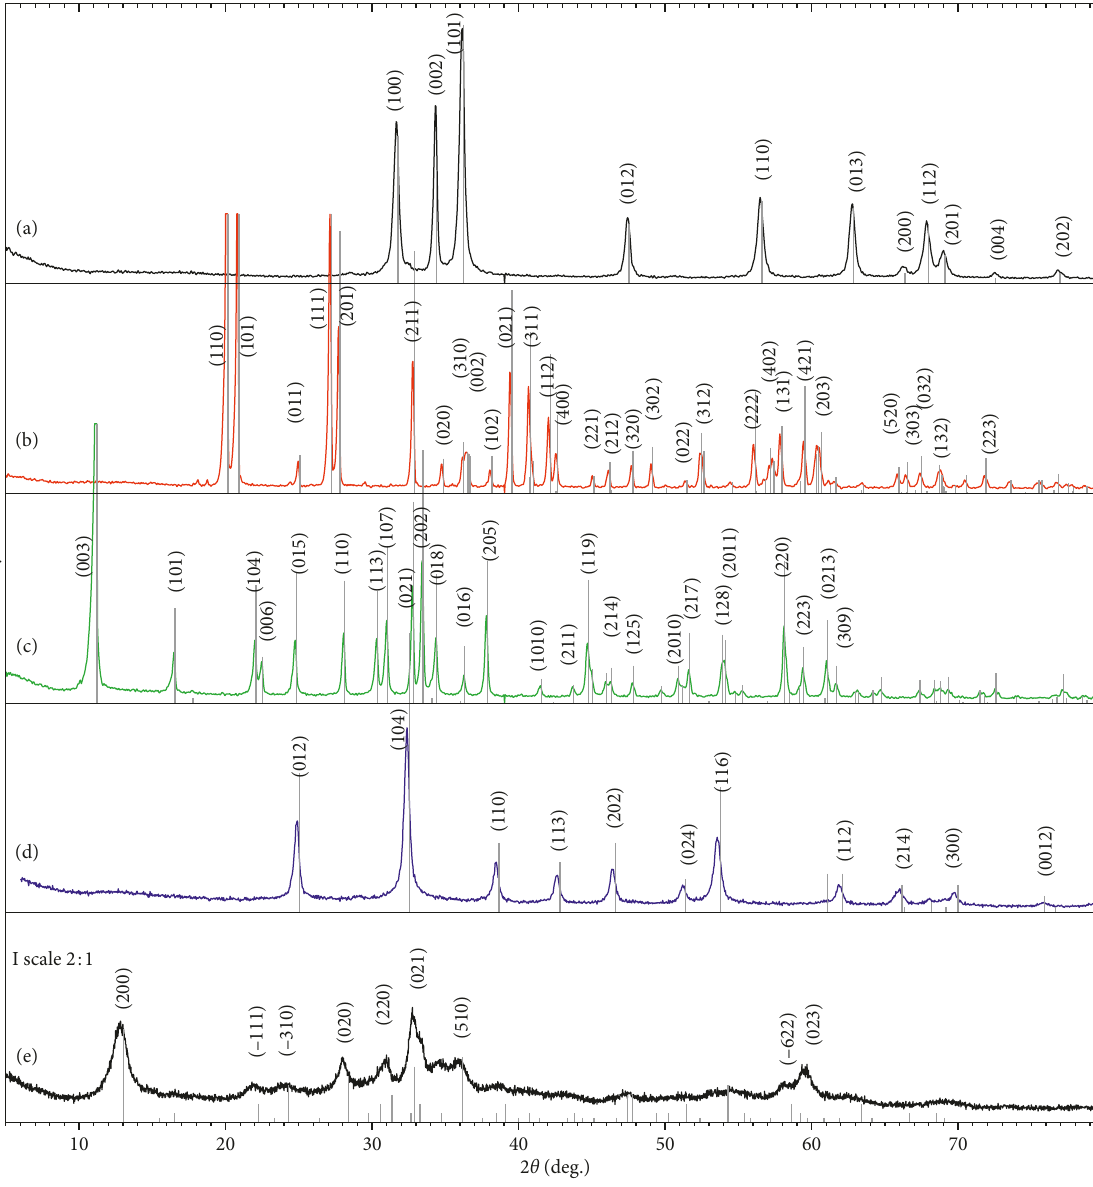
Figure 1: XRD patterns of synthesized ZnO (a), Zn(OH) 2 (b), Zn 5 (OH) 8 Cl 2 · H 2 O (c), ZnCO 3 (d), and Zn 5 (CO 3 ) 2 (OH) 6 (e) powders prepared by the precipitation or solid-state (ZnCO 3 )